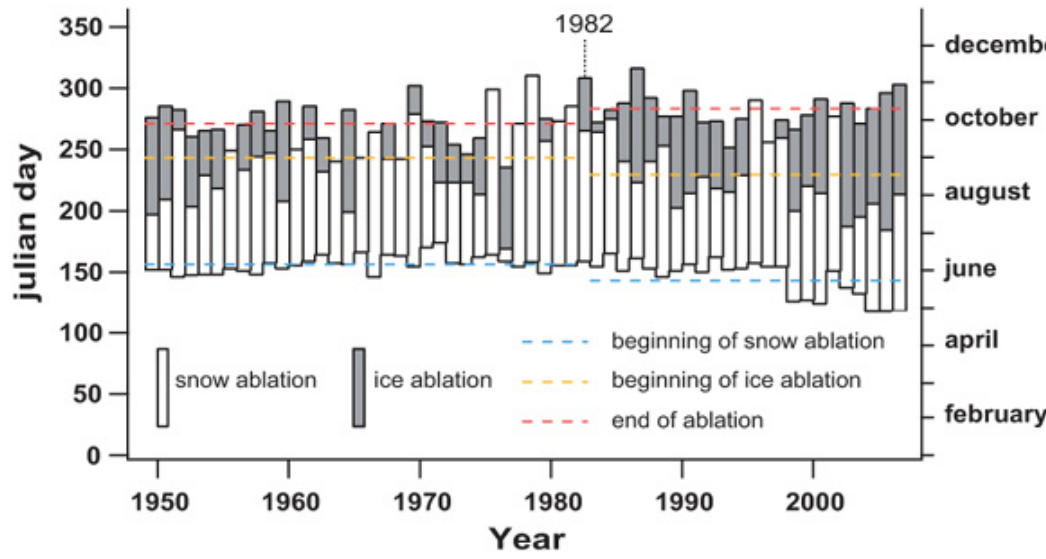
Fig. 9. Ablation start, end and duration for snow and ice at stake 4 over the 6 decades at Sarennes. Dashed lines are mean values before and after the breakpoint identified in 1982 for the summer balance.